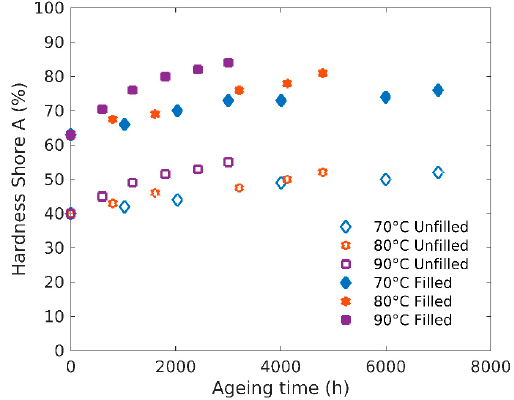
Figure 7. Hardness Shore A evolution with ageing time.